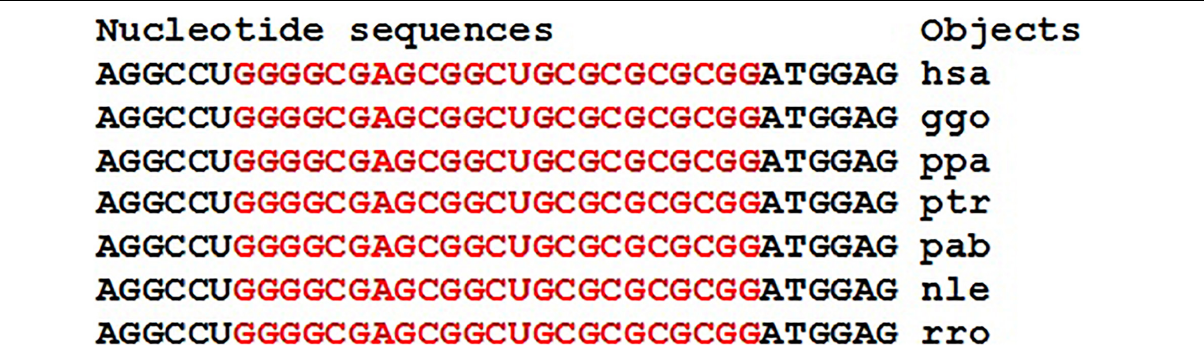
FIGURE 8 | Nucleotide sequences of the CDSs mRNAs regions of orthologous APOE genes containing binding sites of ID01030.3p-miR and ID03261.3p-miR.